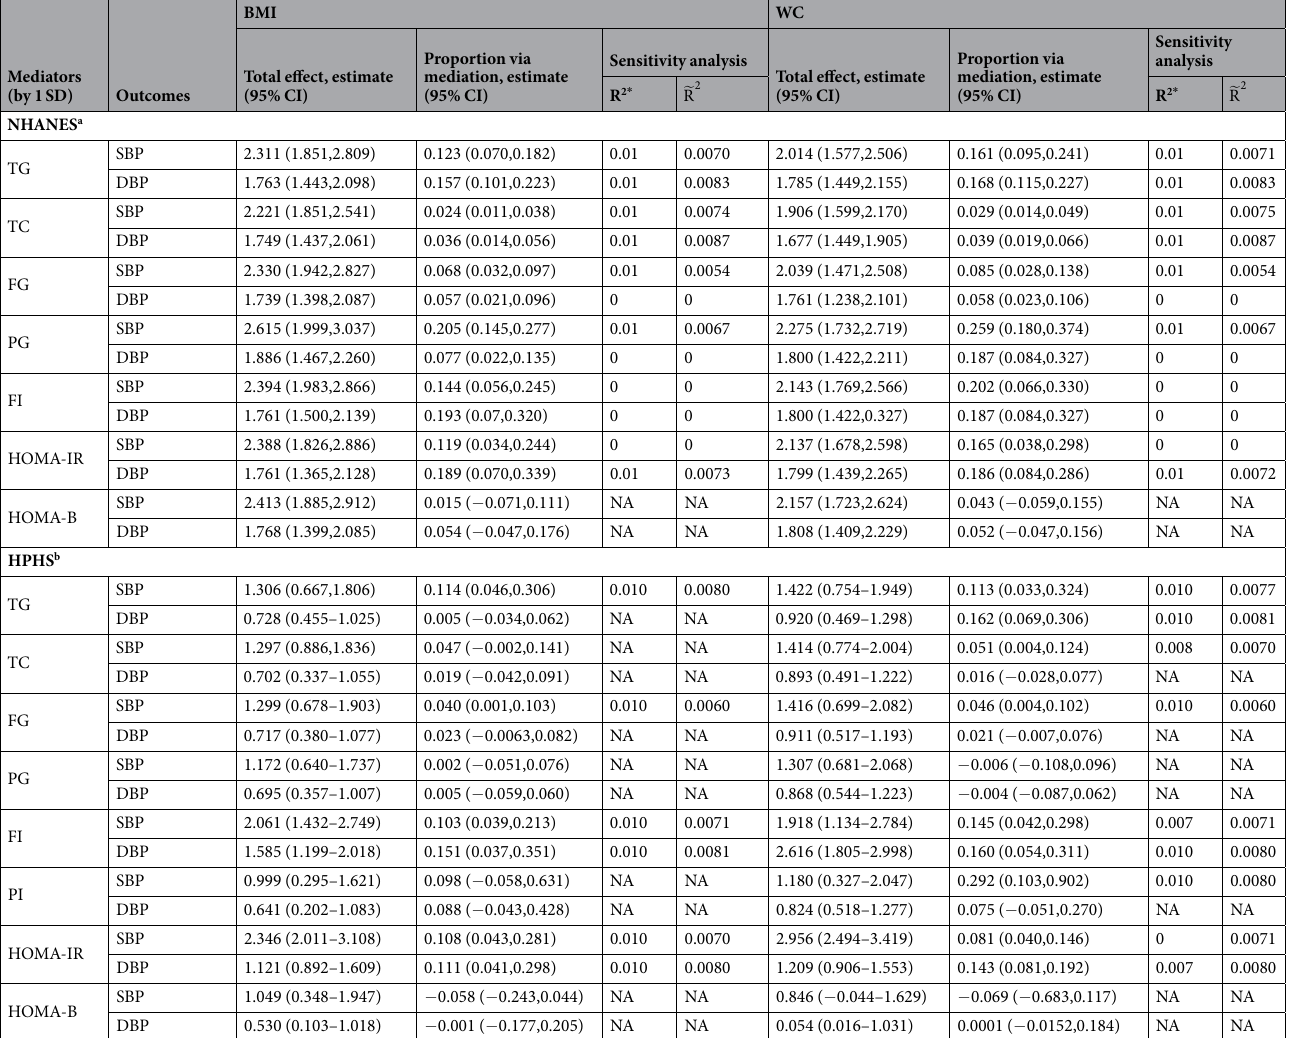
Table 4. Mediation analysis between BMI or WC and blood pressure in the US National Health and Nutrition Examination Survey (NHANES) and in the Harbin People’s Health Study (HPHS, 2008–2012). Abbreviation: BMI, body mass index; WC, waist circumference; SBP, systolic blood pressure; DBP, diastolic blood pressure; TG, triglyceride; TC, total cholesterol; FG, fasting glucose; PG, 2-h postprandial glucose; FI, fasting insulin. a Adjusted for age, sex, ethnicity, exercise regularly, current smoking, current drinking, diabetes mellitus, cardiovascular disease, and total energy intake. b Adjusted for age, sex, current smoking, current drinking, exercise regularly, type 2 diabetes, cardiovascular disease, family history of hypertension, and total energy ∼ 2 R intake. R 2 * , the proportion of residual variances and , the proportion of original variances that were explained by the omitted